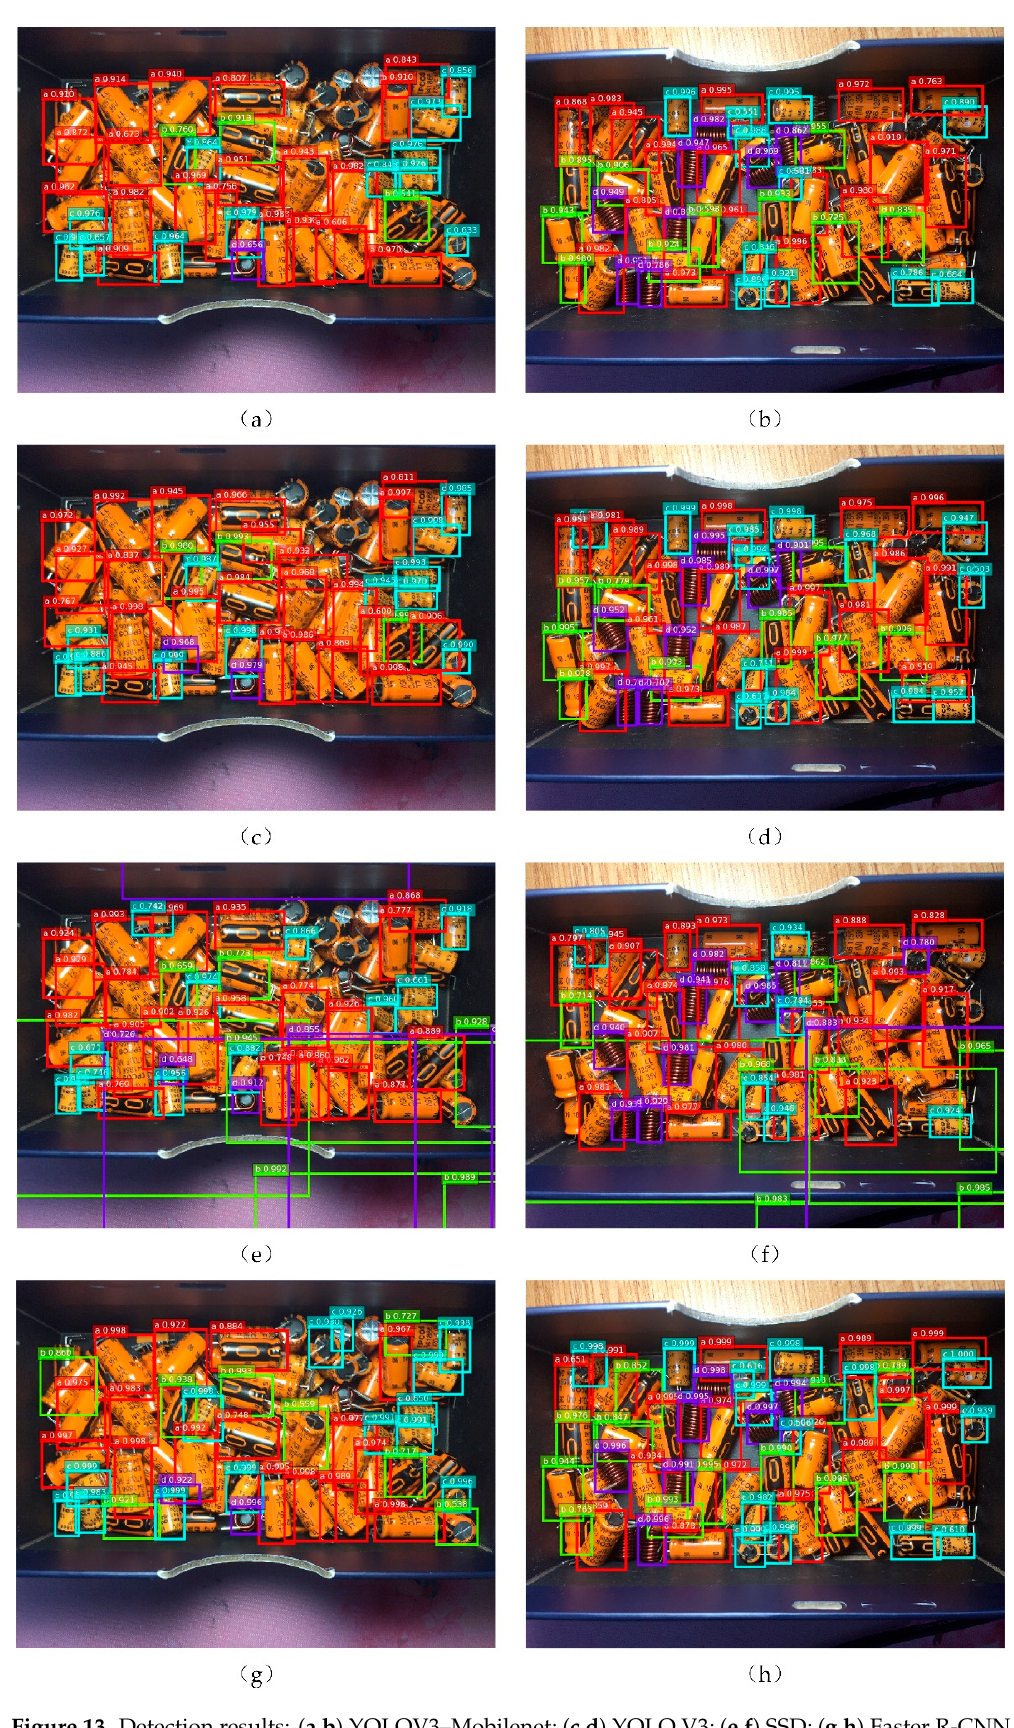
Figure 13. Detection results: ( a , b ) YOLOV3–Mobilenet; ( c , d ) YOLO V3; ( e , f ) SSD; ( g , h ) Faster R-CNN with Resnet 101.